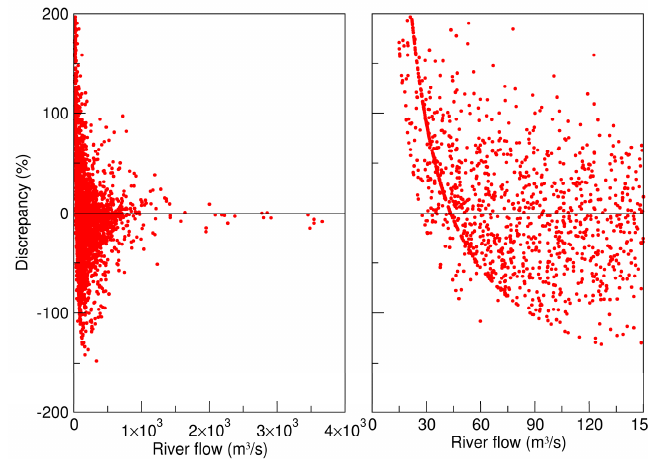
Figure 5. Comparison between the discrepancy and the river flow.